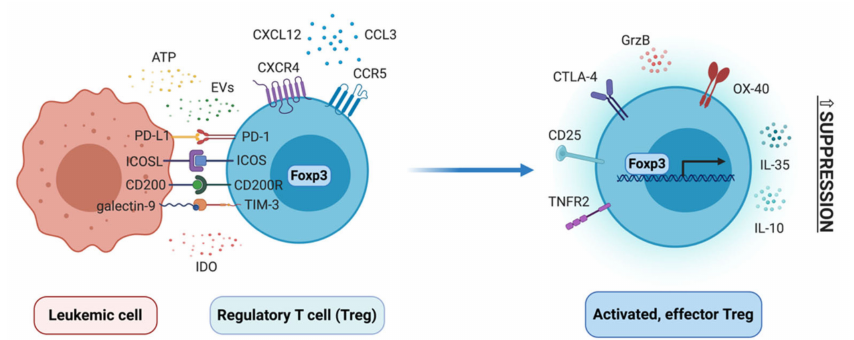
Figure 4. Biology of regulatory T cells in myeloid leukemias. Several receptors and factors expressed and released by leukemic cells, following interaction with their respective receptors/ligand, may drive differentiation of activated, effector Treg. Treg homing to bone marrow may be induced by chemokines, such as CXCL12 or CCL3. Activated, effector Treg in myeloid leukemias upregulate several suppressive markers and inhibit effector immune response. ATP–adenosine triphosphate; EVs–extracellular vesicles; PD-1–programmed cell death protein 1; PD-L1–programmed death